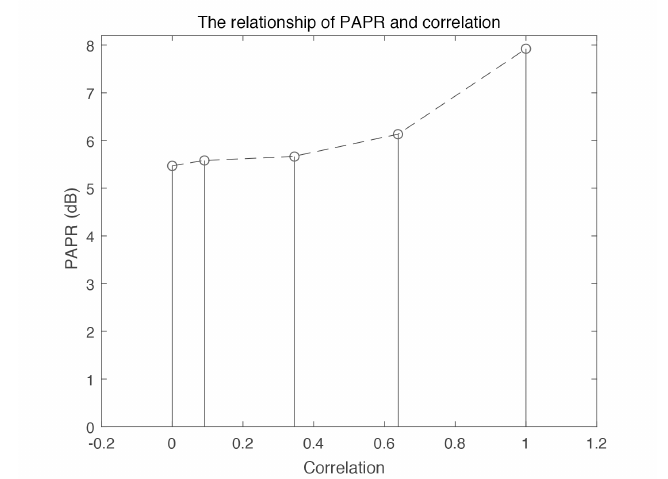
Figure 3. Amplitudes distribution of identical